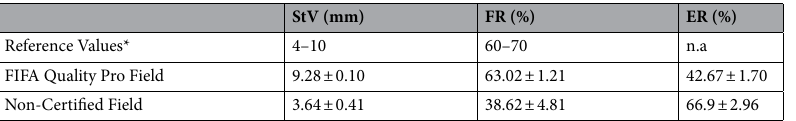
Table 1. Mechanical properties of the selected artificial turf systems and reference values. *Reference values for FIFA Quality Pro field test requirements (FIFA, 2015). StV = Standard Vertical Deformation; FR = Force Reduction; ER = Energy Restitution; n.a. = not